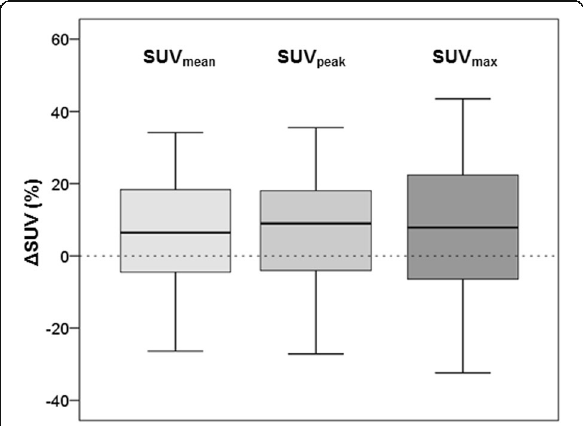
Fig. 2 Δ SUV variability for SUV mean , SUV peak and SUV max between cPET and dPET across all lesions ( n = 128). The average variability in Δ SUV Δ SUV max was larger than the variability in mean ( p = 0.002) and Δ SUV Δ SUV peak ( p = 0.03). Furthermore, max had a higher variance as compared with Δ SUV mean and Δ SUV peak ( p < 0.001). This boxplot shows the median and the interquartile